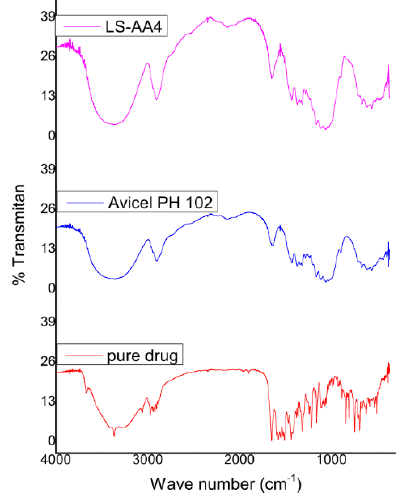
Figure 3. IR spectrum of the liquisolid tablet AA4, Avicel PH 102, and pure drug atorvastatin calcium